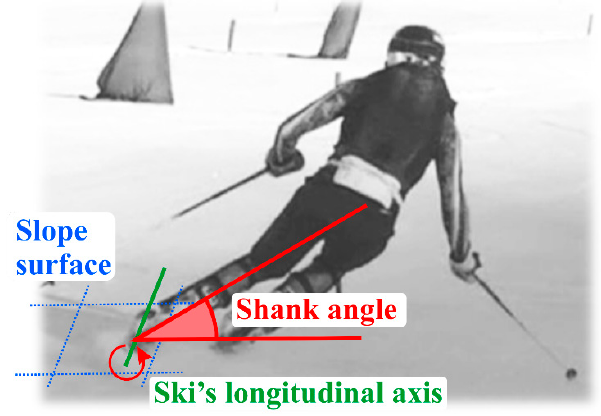
Figure 3. Photograph of a skier illustrating the angle of the shank.